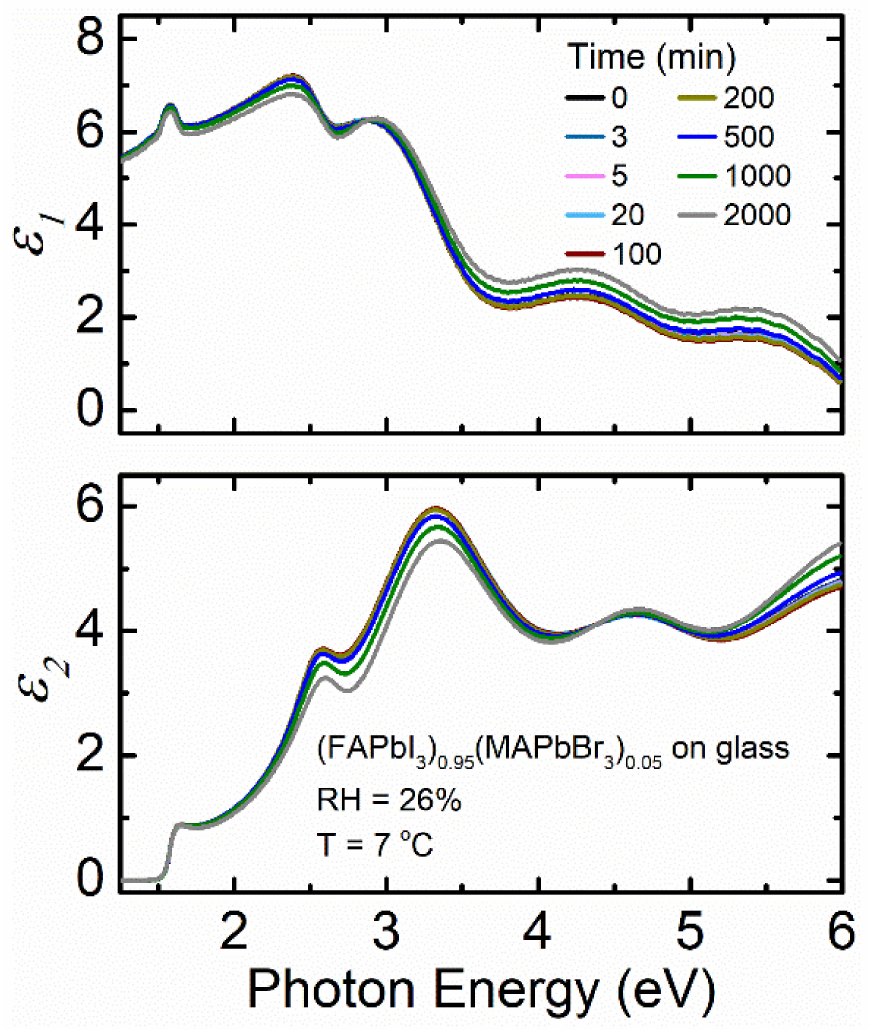
Figure 6. Spectra in ε at selected time points for thin film (FAPbI 3 ) 0.95 (MAPbBr 3 ) 0.05 deposited on soda lime glass as a function of photon energy when exposed to 26% RH at 7 ◦ C. RH is introduced at 5